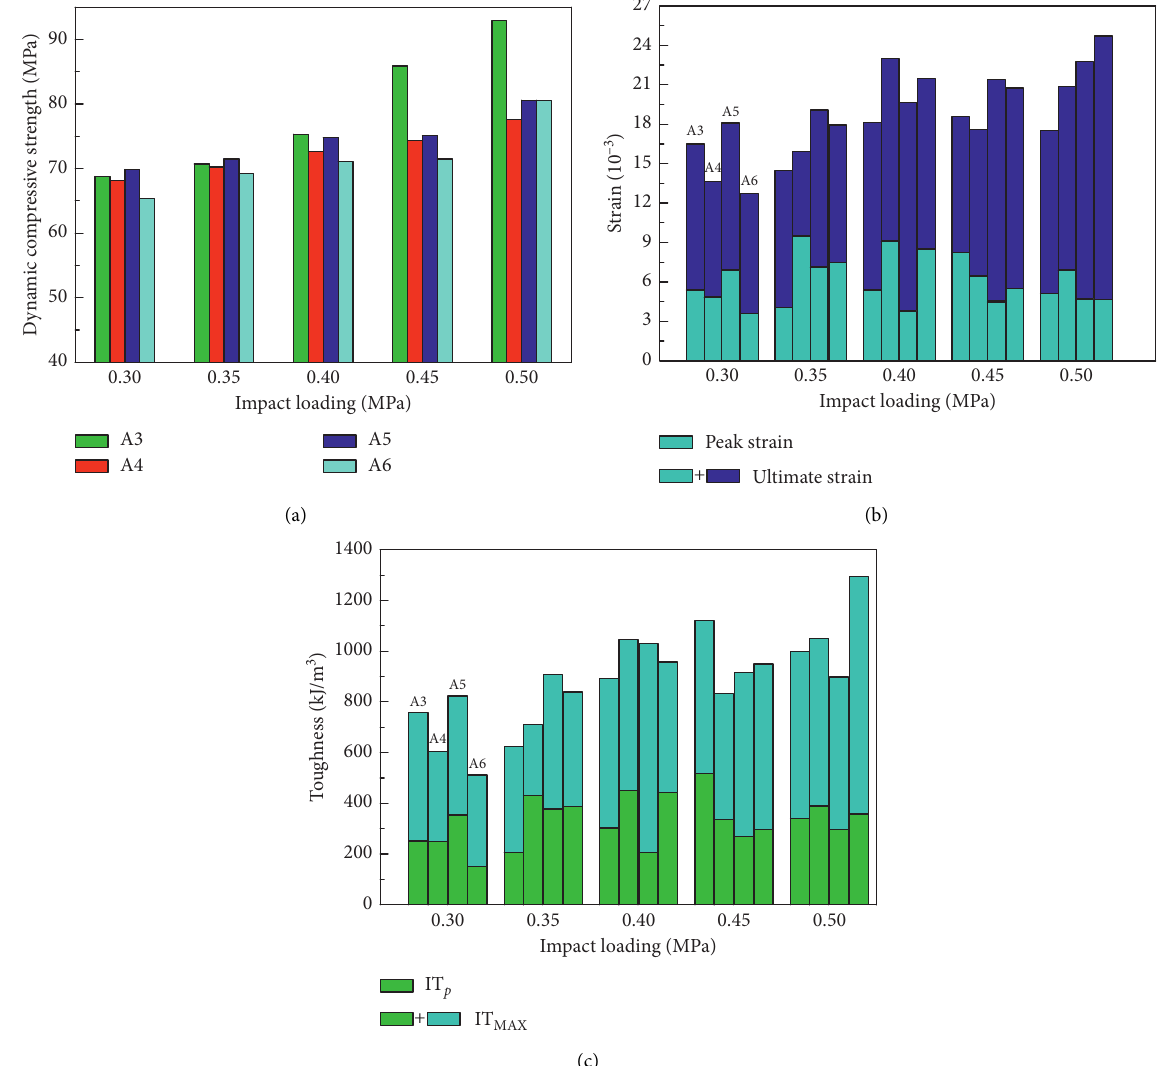
Figure 7: Comparison of dynamic properties between different fiber hybridizations: (a) on dynamic compressive strength, (b) on peak strain and ultimate strain, and (c) on IT P and IT MAX